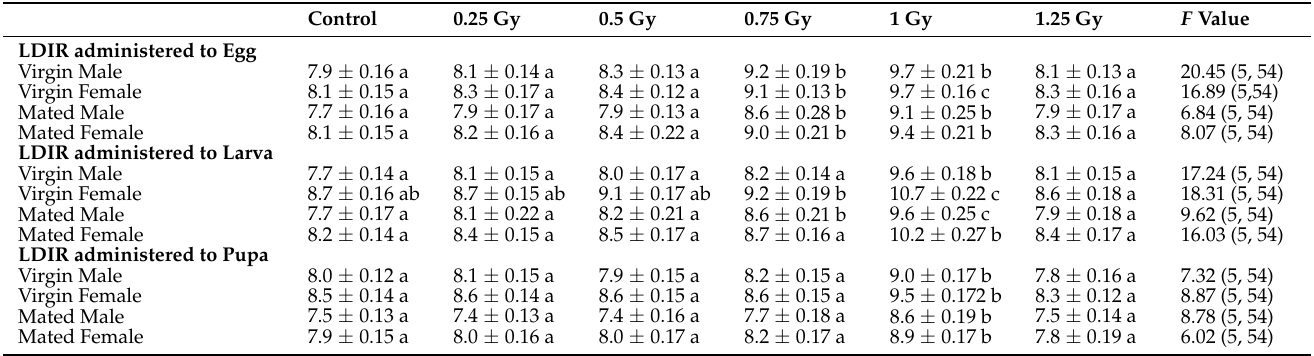
Table 3. Effect of low-dose ionizing radiation (LDIR) on the longevity of Spodoptera litura treated in various ontogenetic stages.